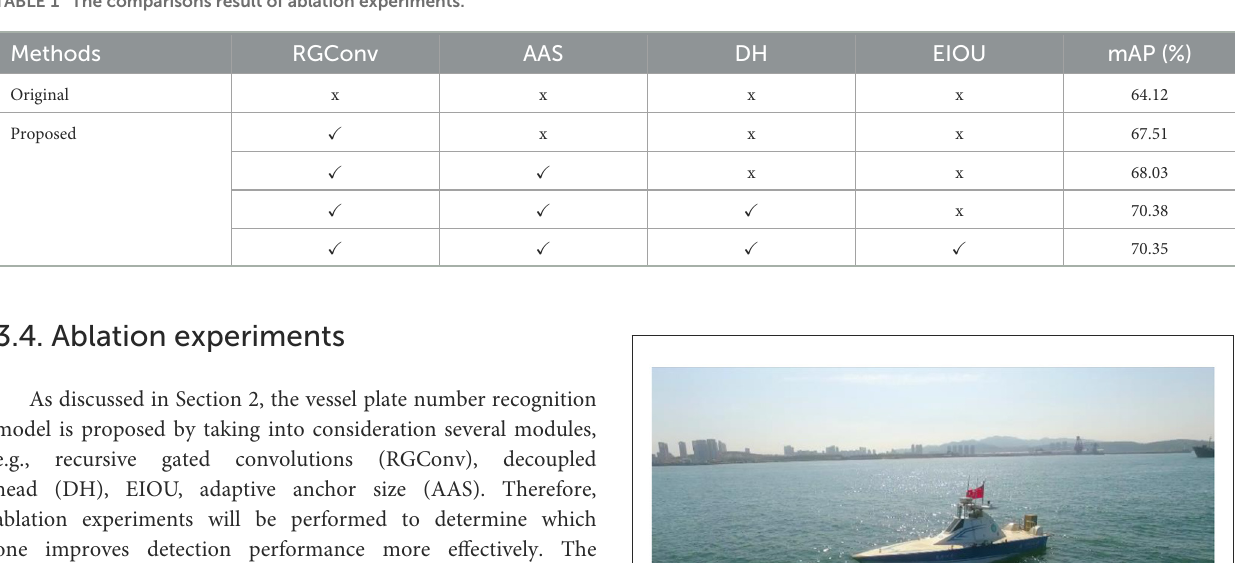
TABLE 1 The comparisons result of ablation experiments.